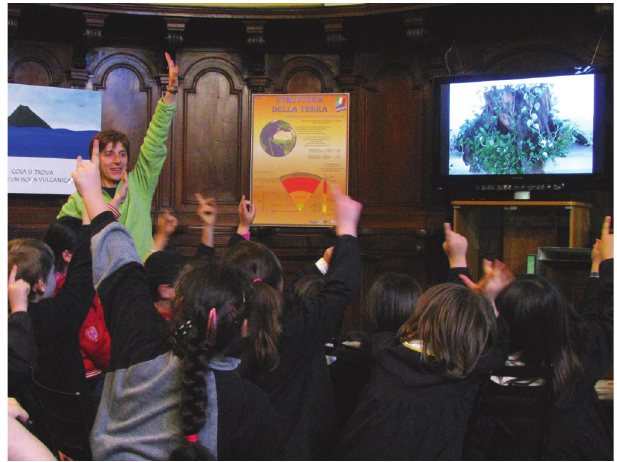
Figure 7. Children express their opinions about the geological